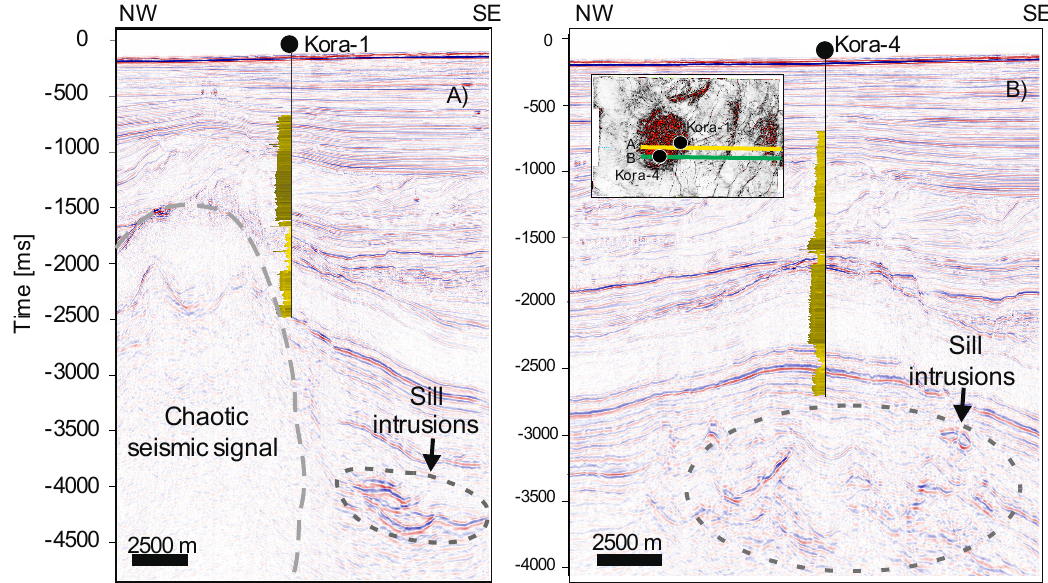
Figure 6. NW-SE sections from Kora 3D with projected Kora-1 and Kora-4 wells. ( A ) Inline 1205 with Kora-1 well projected on it from 300 m; ( B ) Inline 1127 directly intersecting Kora-4 well.